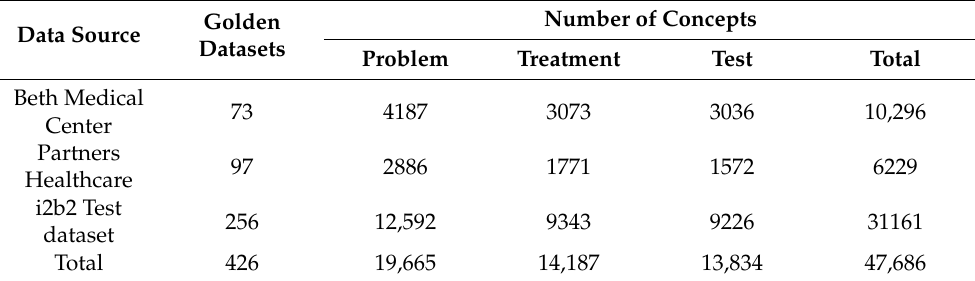
Table 5. All the datasets and their details, provided by i2b2 National Center.